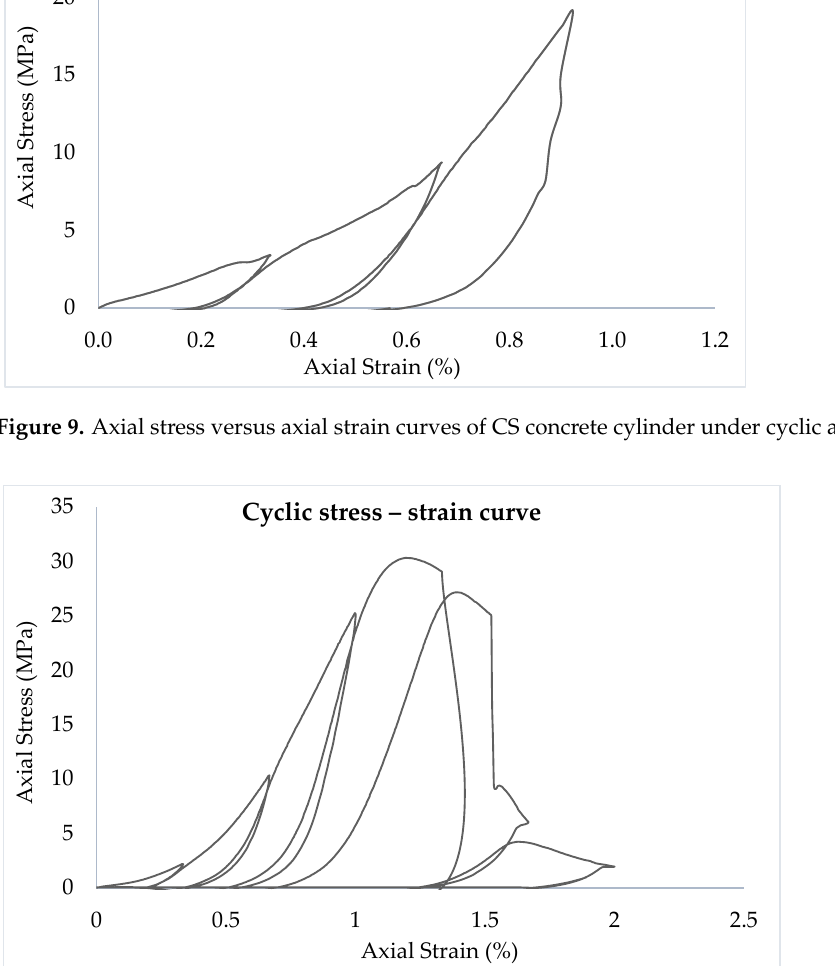
Figure 11. Axial stress versus axial strain curves of C-C1S2 concrete cylinder confined with MWCNT incorporated epoxy-based SFRP under cyclic axial load. Figure 12. Axial stress versus axial strain curves of C-C0S2B2 concrete cylinder confined with epoxy- based HSBFRP under cyclic axial load.